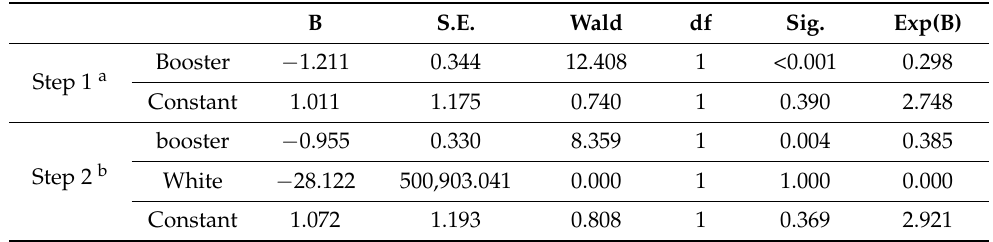
Table 2. Model equation for logistic regression for vaccine uptake.